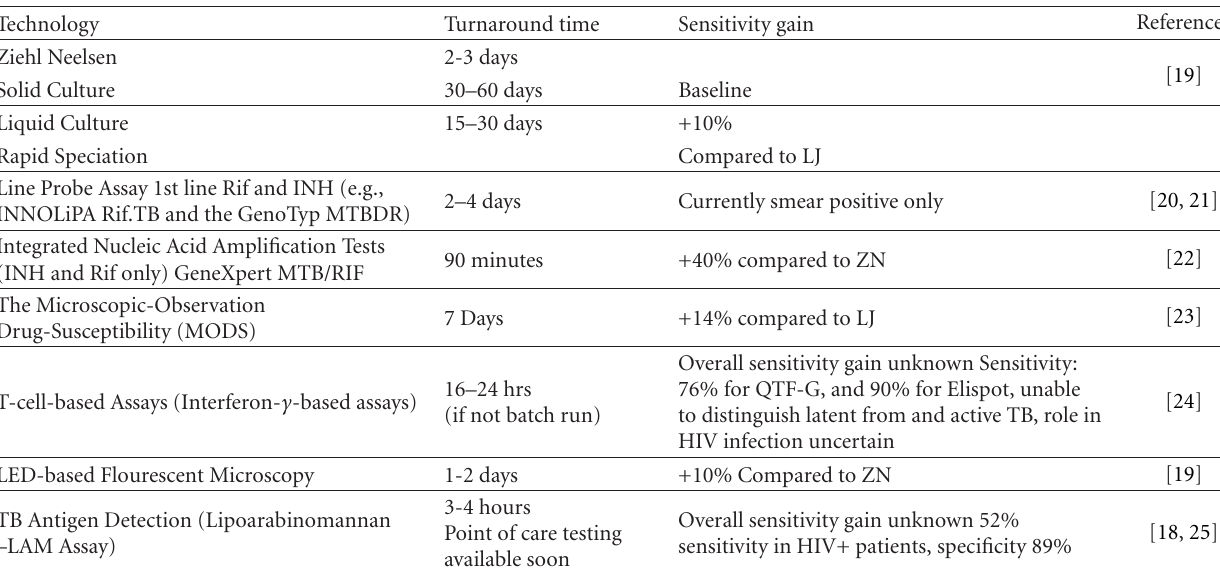
Table 1: Newer Diagnostic Technologies for